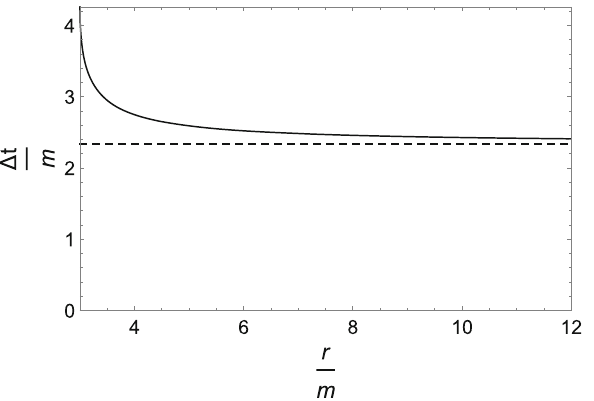
Fig. 1 Thetimedifferencebetweentheoccurrenceoftheeventhorizon and photon surface. The limit value is (( 9